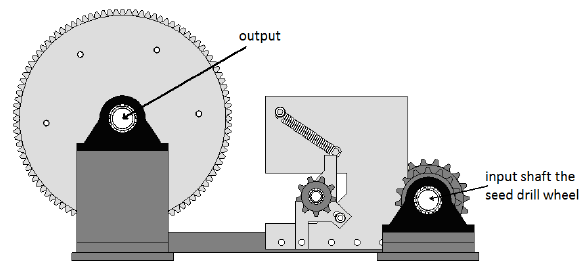
Figure 4: Changing the rotational speed of seed metering drive shaft using the belt mechanism wheel C. Using magnetic clutch and chain drive: In this method, the multi-wheel chains, which are mounted between the propeller axis and the propeller axis, are used for different planting rates (Figure 5). All wheel chains are free of charge on the axis of the vehicle. In this method, using an electric clutch, according to the desired seed rate, one of the chain wheels is locked on the axis of the clutch [3].